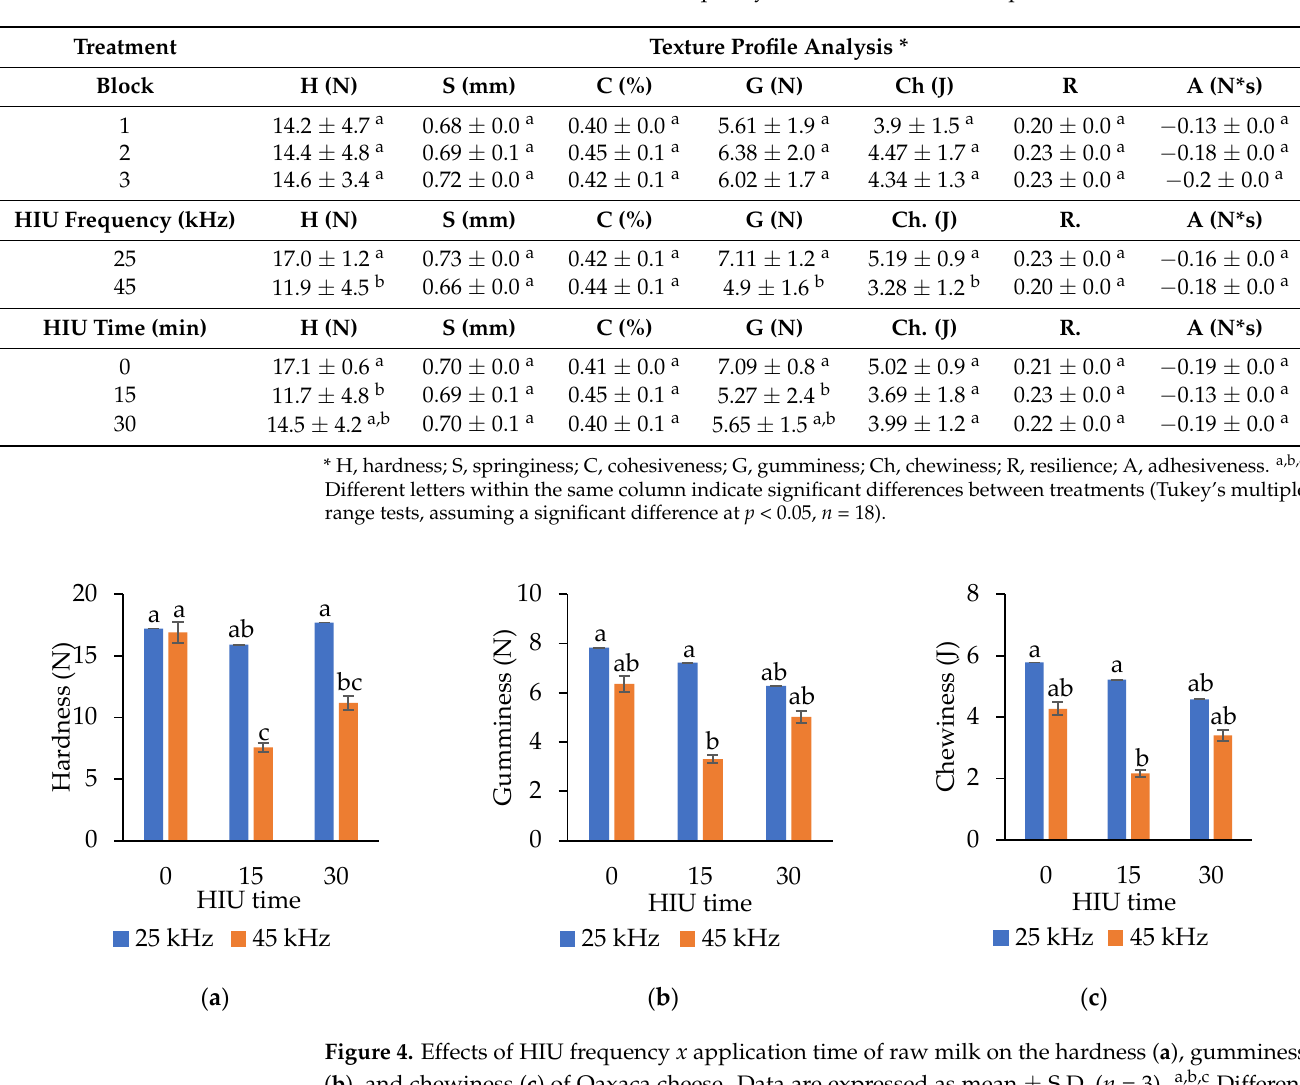
Table 3. Effects of blocks and HIU frequency and time on the texture profile of Oaxaca cheese.